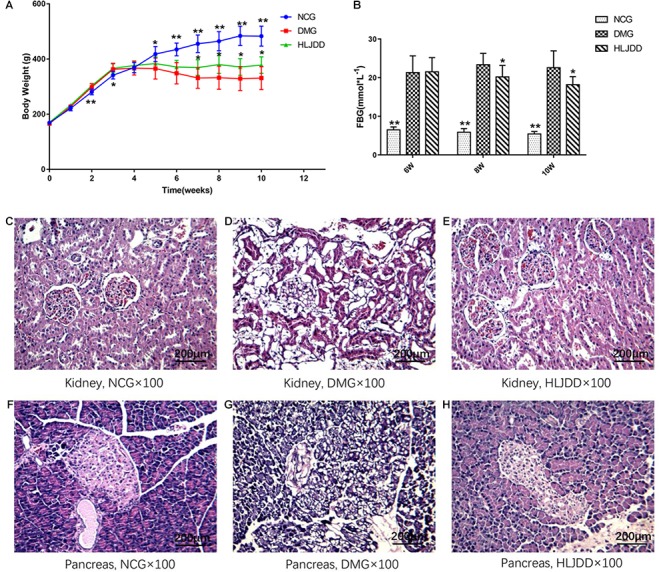
Effects of HLJDD on body weight gain, fasting blood glucose, and the morphology of the kidney and pancreas in rats. (A) Body weight gains and (B) FBG over the 10-week experiment. (C–H) Micrographs of rat kidney and pancreas specimens from NCG, DMG, and HLJDD treatment groups. Values are expressed as means ± SD. Differences were assessed by ANOVA and denoted as follows: ∗∗p < 0.01, ∗p < 0.05 vs. DMG (n = 8).